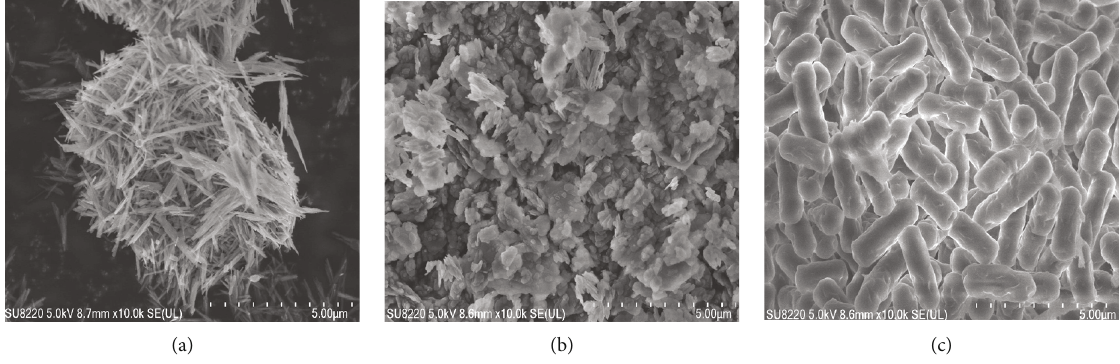
Figure 1: SEM images of (a) goethite, (b) kaolinite, and (c) Bacillus cereus cell.